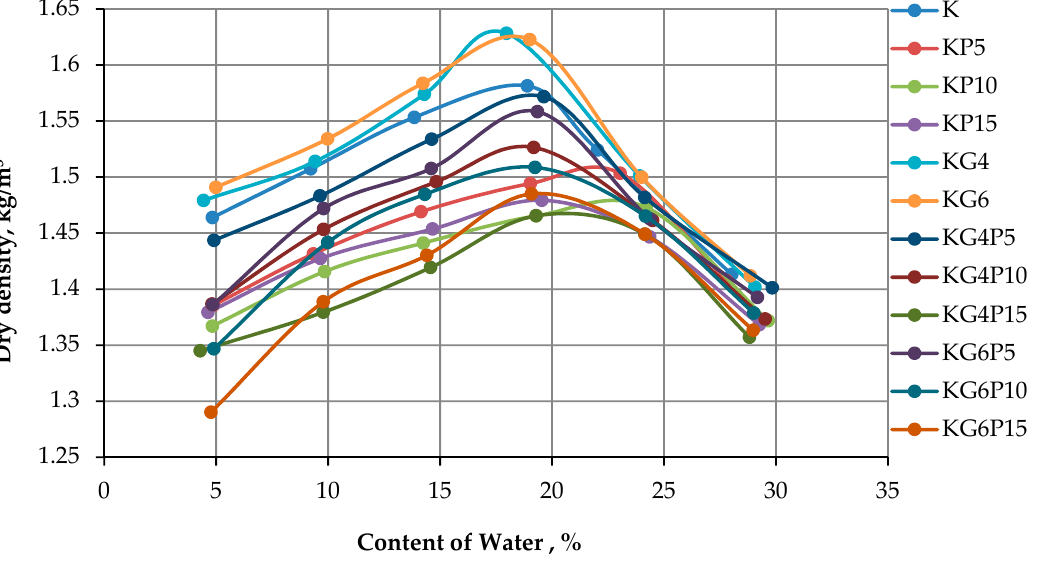
Figure 4. Variation of MDD and OMC of solo kaolin and stabilized kaolin with POFA and gyp- sum.